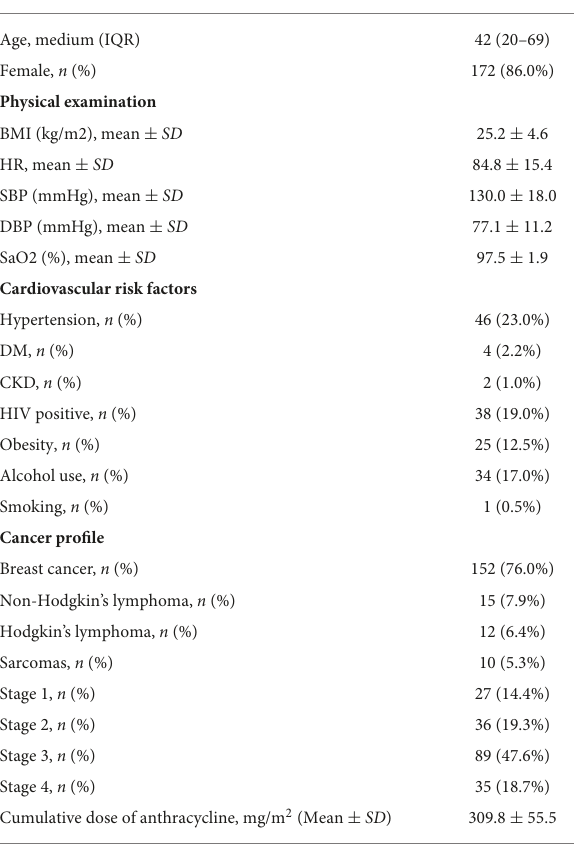
TABLE 1 Patients baseline